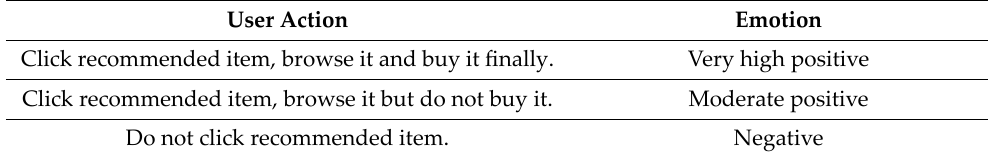
Table 1. Different action and different